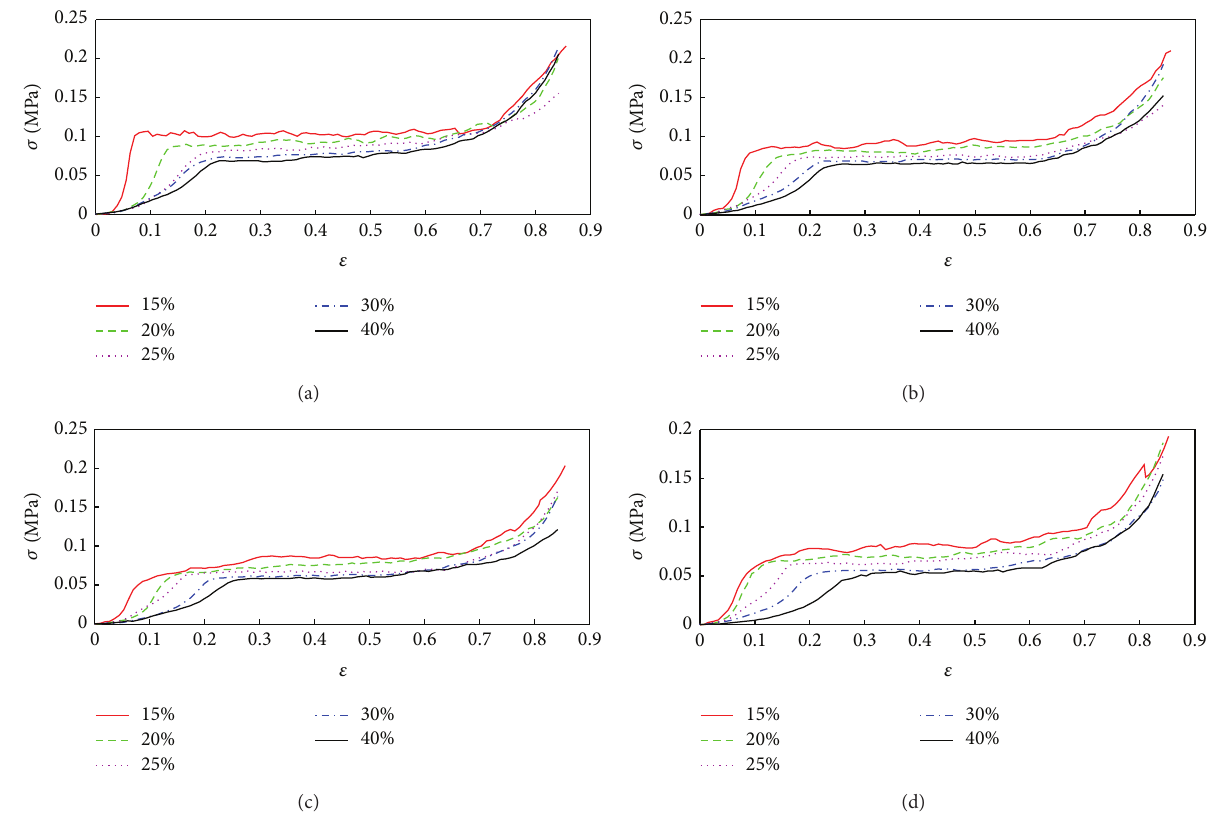
Figure 2: Effect of fatigue stress-strain relationship of various precompression honeycomb paperboard ( 𝑡/𝑙 = 0.0263 ) (a) 𝑛 = 10000 , (b) 𝑛 = 20000 , (c) 𝑛 = 30000 , and (d) 𝑛 = 50000 .